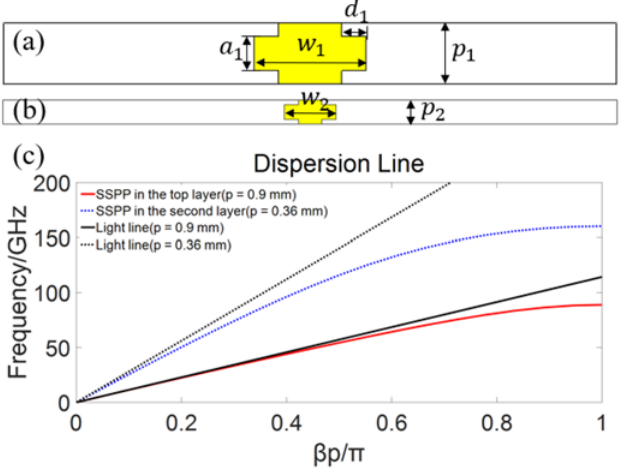
Fig. 2. The proposed multi-layer SSPP TL. (a) Top view of the top copper layer. (b) Top view of the second copper layer. (c) Sketch of the layer